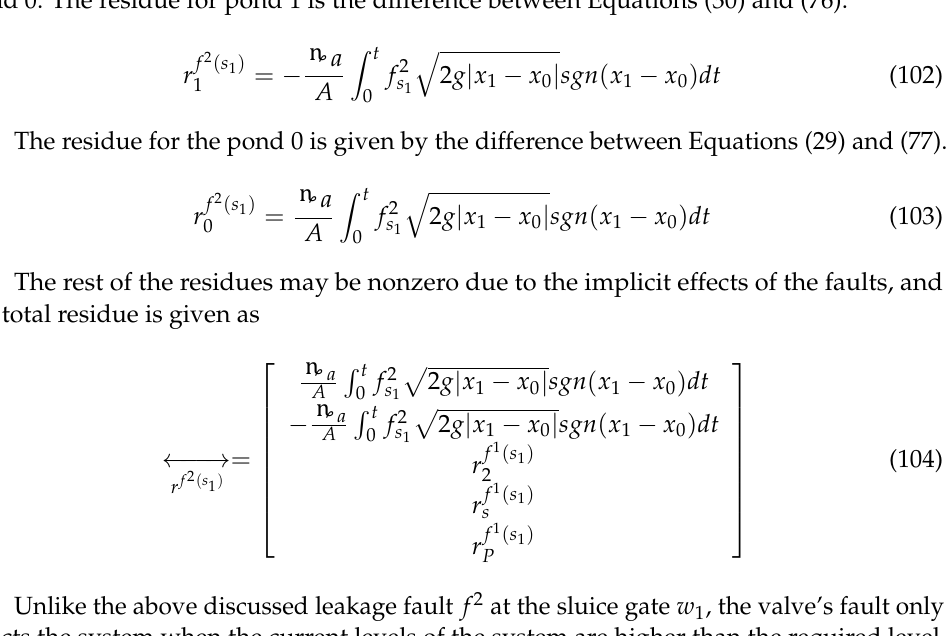
Figure 1. Three-pond hydraulic system.